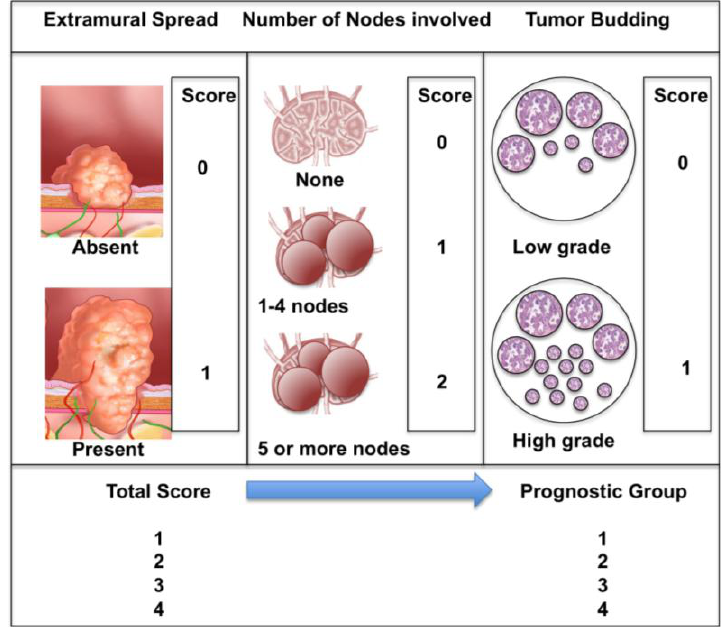
Figure 1. The Jass Classification (Ueno et al. , 2004 [17]): not in order Tumor is scored in three areas; extramural spread, positive nodes and tumor budding. The total score place it in a prognostic